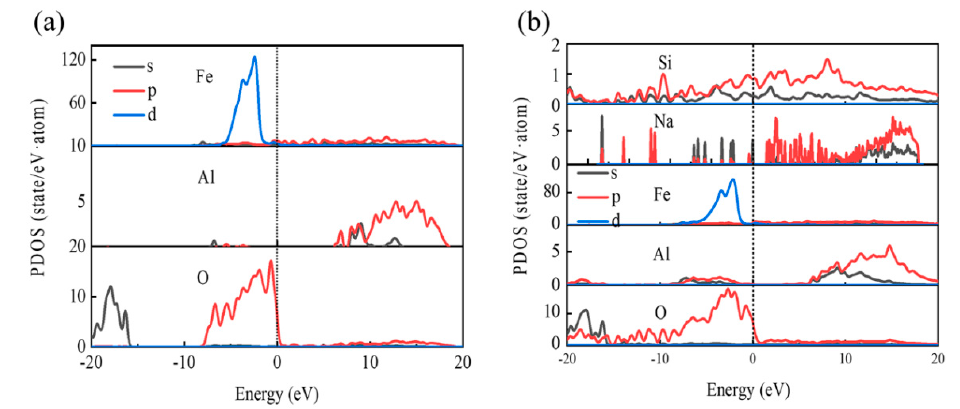
Figure 12. The partial density of states (PDOS) for the ( a ) Fe-Al 2 O 3 and ( b ) Fe − amorphous Na 2 SiO 3 - Al 2 O 3 interfaces. Al 2 O 3